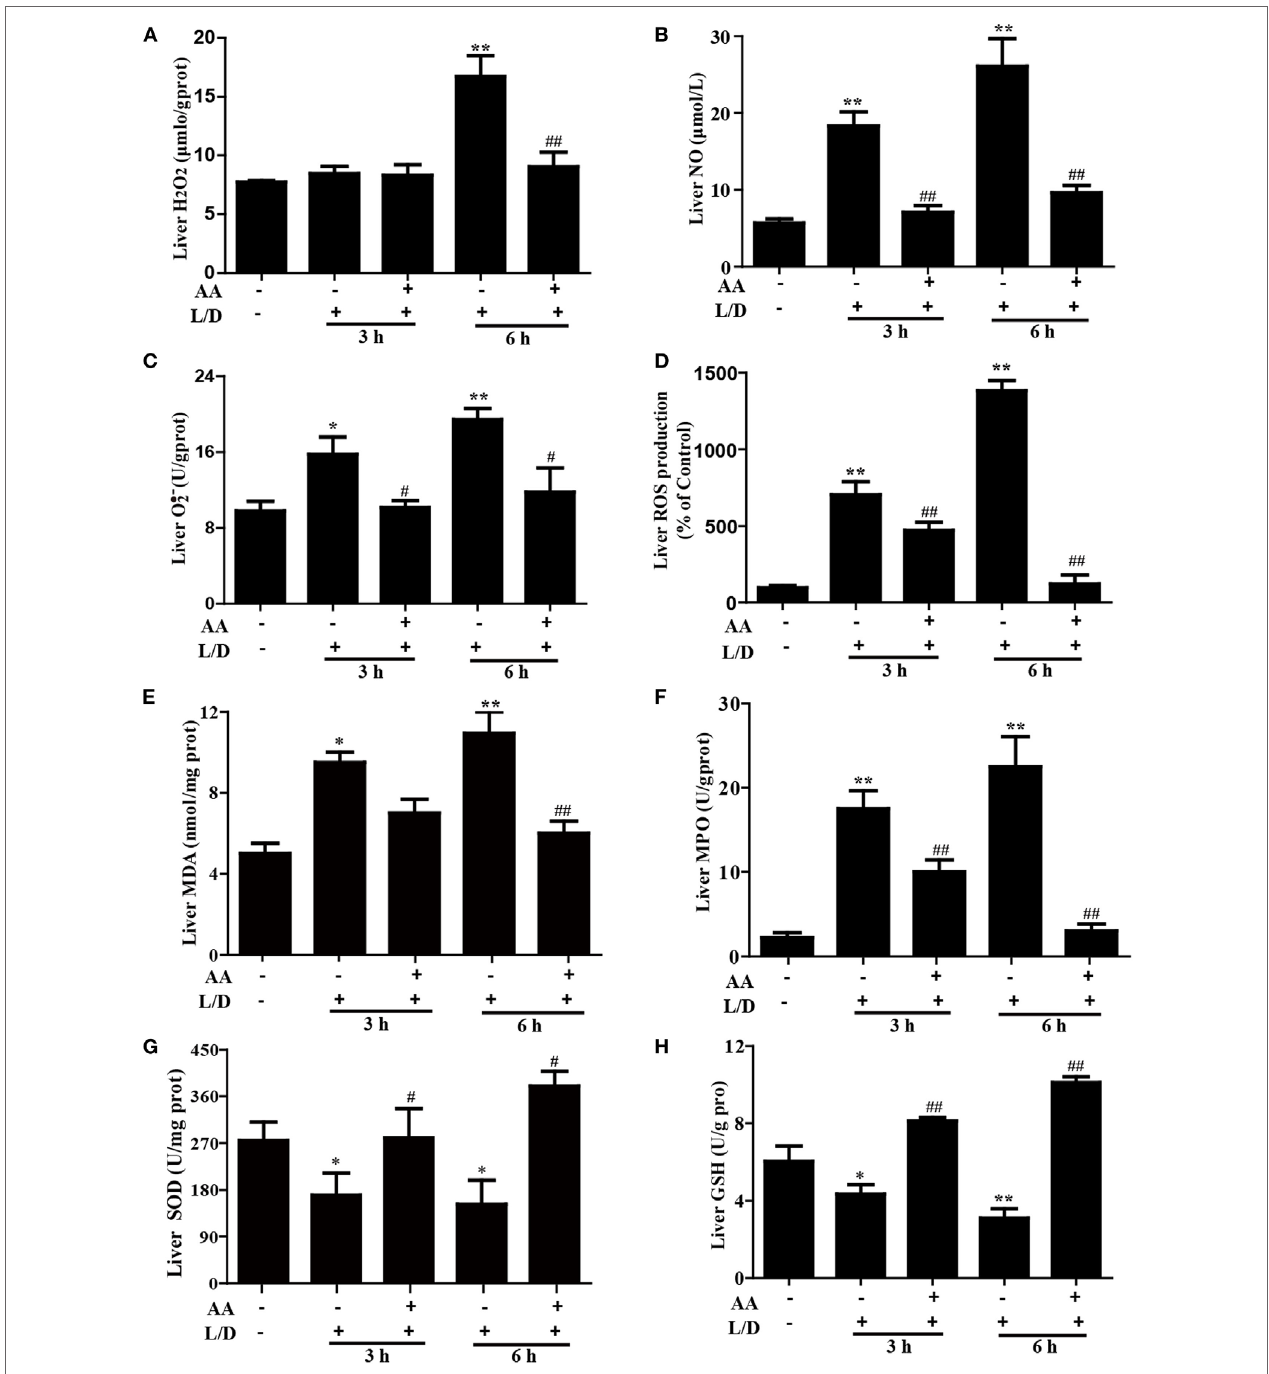
FigUre 4 | Effects of asiatic acid (AA) treatment on the levels of oxidative markers in L/D-induced fulminant hepatic failure. Liver tissues were collected from the mice 3 or 6 h after L/D challenge for measurement of the generation of H 2 O 2 , NO, O 2 − , and reactive oxygen species (ROS), formation of malondialdehyde (MDA) and myeloperoxidase (MPO), and the superoxide dismutase (SOD) and glutathione (GSH) activities. (a–D) Effects of AA on liver H 2 O 2 , NO, O (e,F) Effects of AA on the liver MDA and MPO levels. (g,h) Effects of AA on the liver SOD and GSH activities. Similar results were obtained from three independent experiments. All data are presented as means ± SEM ( n = 5 in each group). * p < 0.05 and ** p < 0.01 vs. control group; # p < 0.05 and ## p < 0.01 vs. L/D